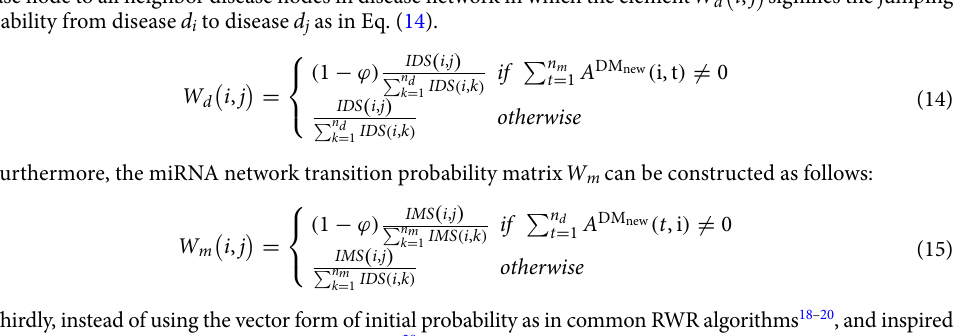
signifies the jumping